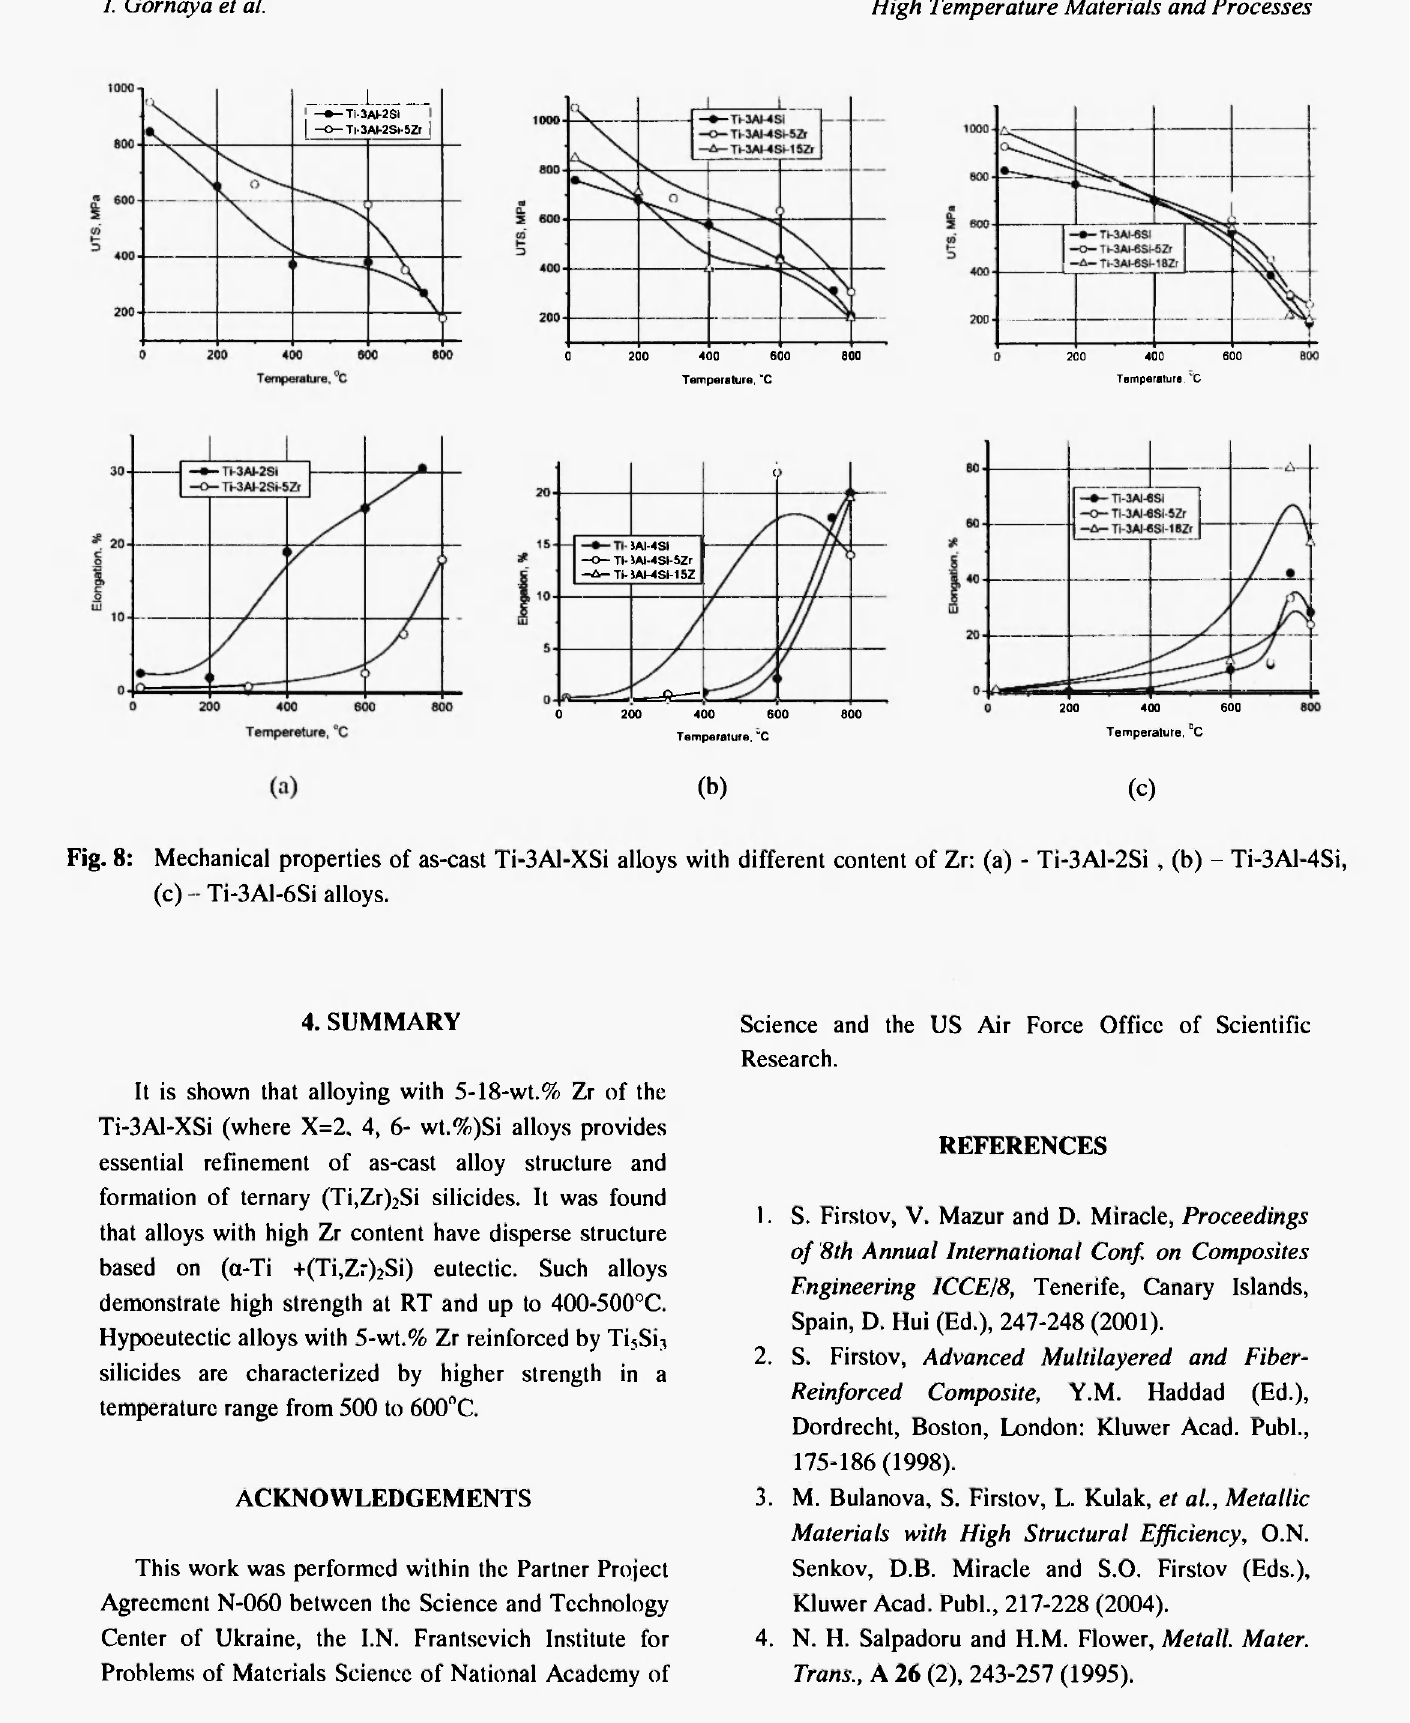
Fig. 8: Mechanical properties of as-cast Ti-3Al-XSi alloys with different content of Zr: (a) - Ti-3Al-2Si , (b) - Ti-3Al-4Si, (c) - Ti-3Al-6Si